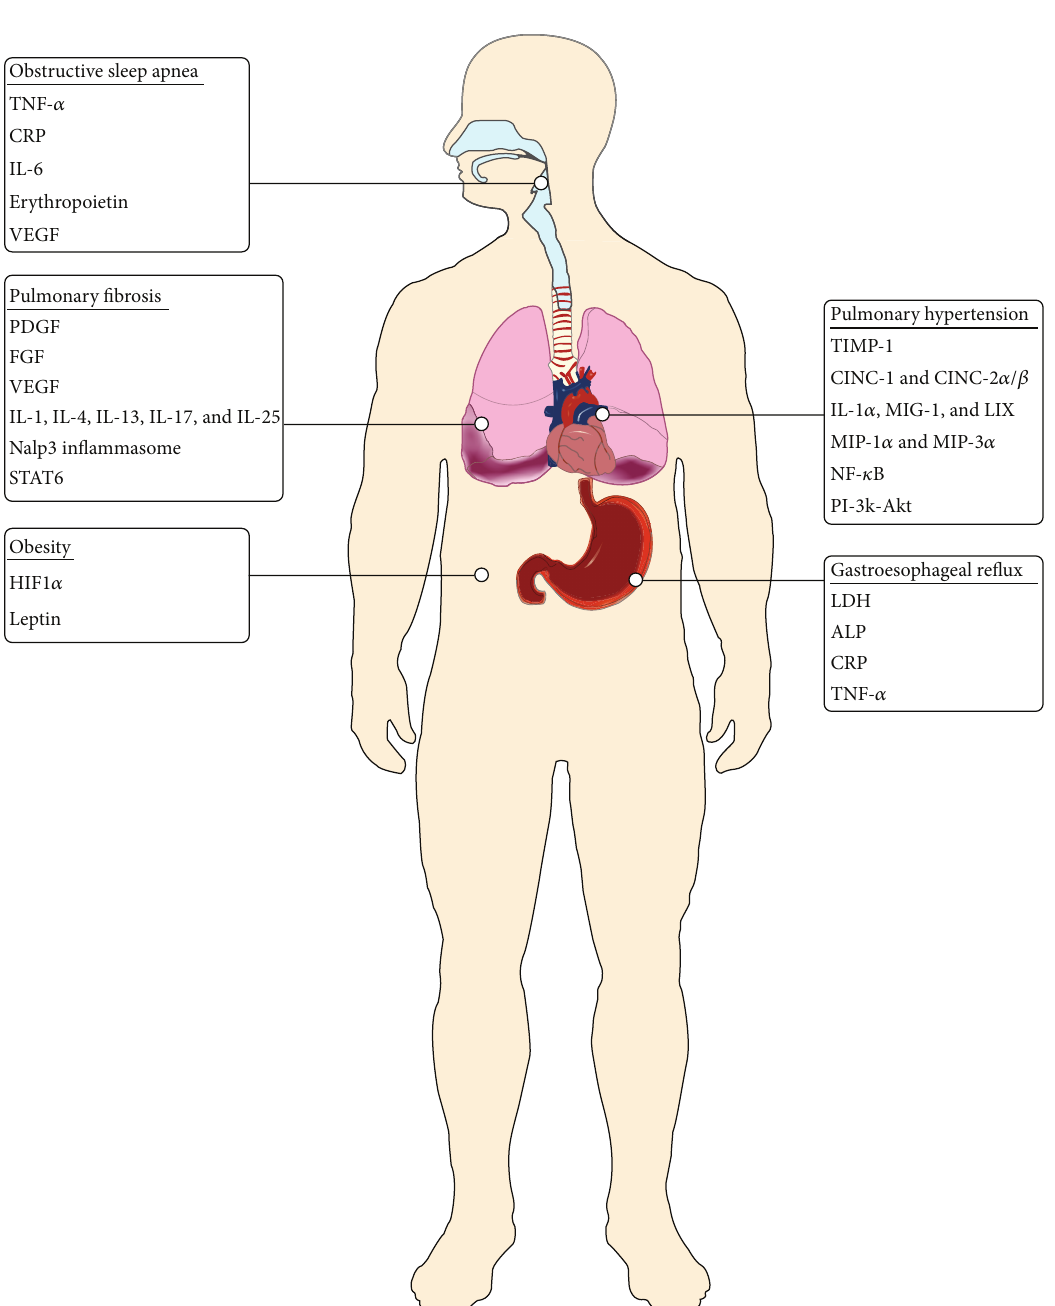
Figure 1: Inflammatory mediators of hypoxemia in coexistent pulmonary fibrosis and sleep